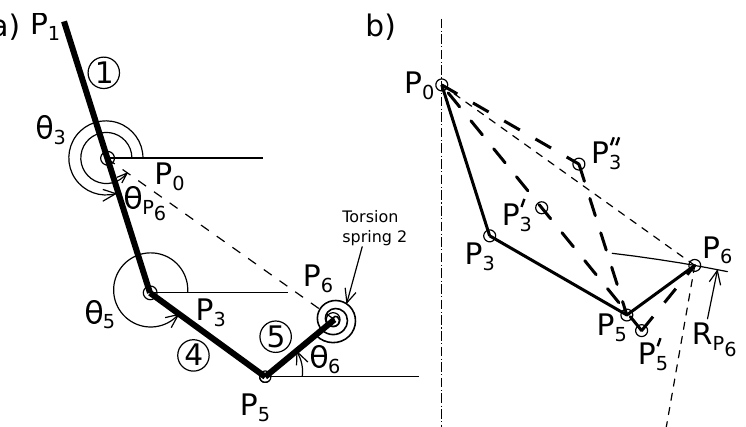
Figure 9. ( a ) Schematic view of chain 2; ( b ) two stable positions on bi-stable